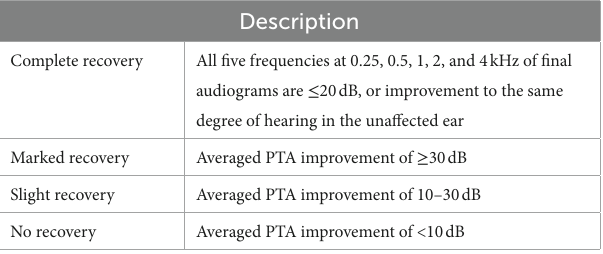
TABLE 2 Final treatment outcomes according to the guideline of the Acute Severe Hearing Loss Study Group of the Ministry of Health, Labor, and Welfare of Japan.